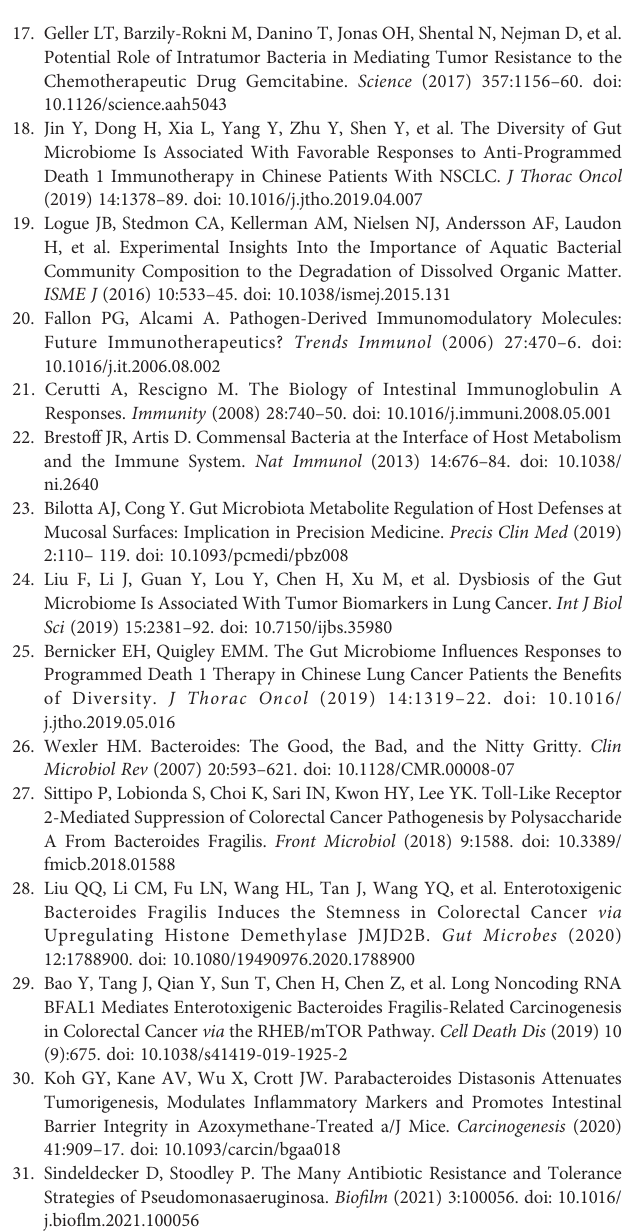
three biomarkers ’ taxa between two groups. (D) The distribution of the top 10 species in two groups. Supplementary Figure 3 | Functional properties of the gut microbiome. (A) 99 pathways were identi fi ed between H and LUAD groups in 16s-rRNA gene sequencing. (B) 84 pathways were identi fi ed between H and LUAD groups in metagenomics. (C) The distribution of 34 overlapping pathways in all samples. (D) The relation of three biomarker ’ s taxa to 34 overlapping pathways. *P < 0.05, **P < 0.01. Supplementary Figure 4 | The differential distribution of three biomarkers ’ taxa (A) between Age ≥ 60 and < 60, (B) between female and male, (C) between BMI ≥ 24 and < 24, (D) between TNM stage I/II and TNM stage III/IV. BMI, Body Mass Index. *P < 0.05, **P <